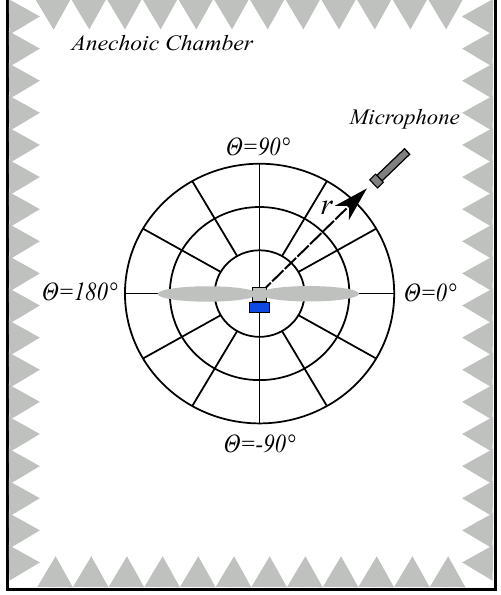
Figure 6. Definition of the polar reference system for the directivity